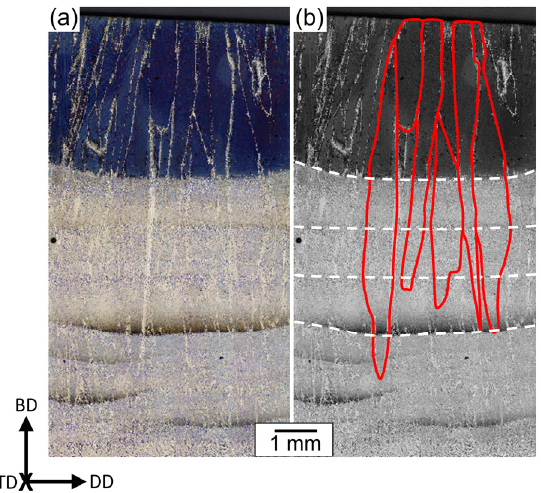
Figure 3. OM images obtained from the polished and etched BD-DD section; ( a ) overview of the cross-section; ( b ) BD-DD cross-section with highlighted grains (red) and beginning of the HAZ (white) in several layers; the sample coordinate system is defined by the building direction (BD), deposition direction (DD) and transverse direction (TD).